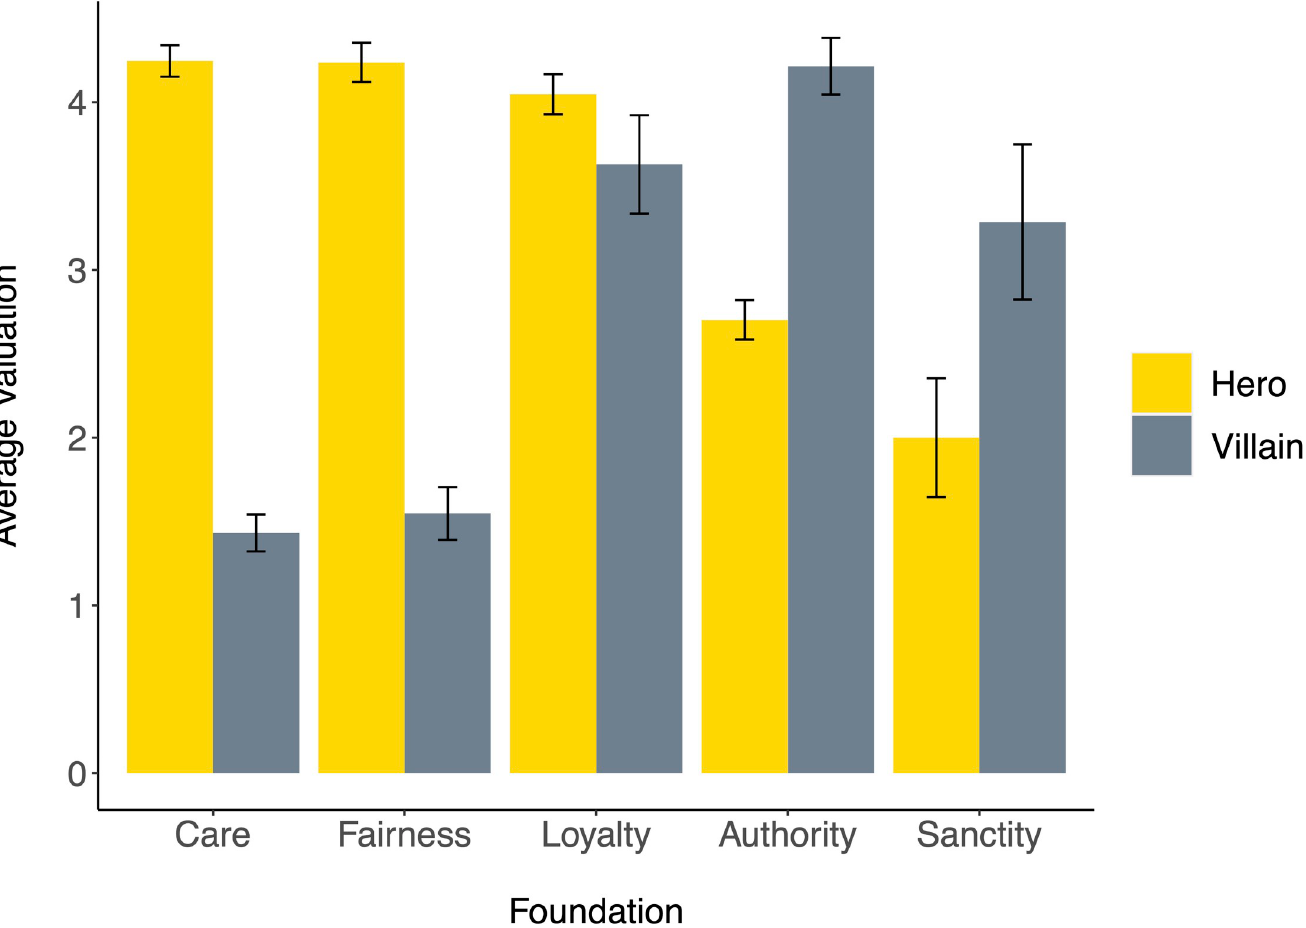
Fig 2. Average valuation of five moral foundations among heroes and villains. Error bars represent ± 1